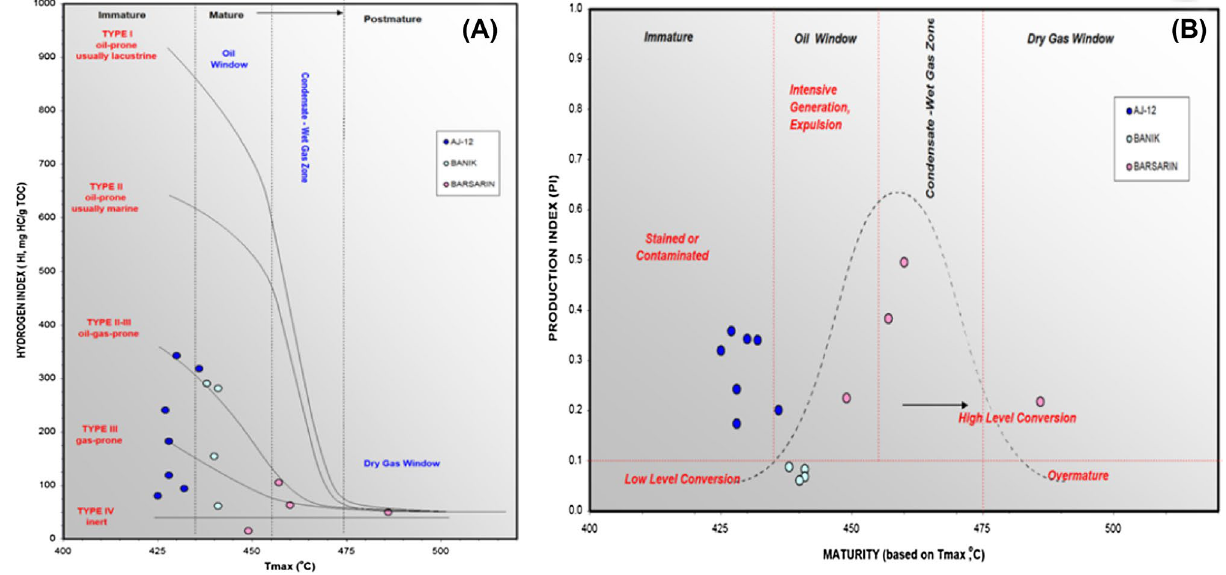
Fig. 13 a Plot of Hydrogen Index (HI) vs. T ples from well Aj-12 are in late stage of immaturity, samples of Banik max of the samples of the area are in the mature stage; however, samples from Barsarin section Chia Gara Formation, b T max vs. Production Index (PI) diagram of the are in the late stage of thermal maturity to postmature Chia Gara Formation. Thermal maturity parameters show that sam-